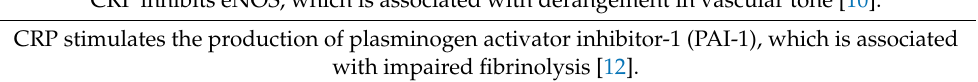
Table 4. Mechanisms of direct influence of CRP and proinflammatory cytokines on atherogenesis. CRP promotes the production of procoagulant tissue factor, leukocyte adhesion molecules, and chemotactic substances